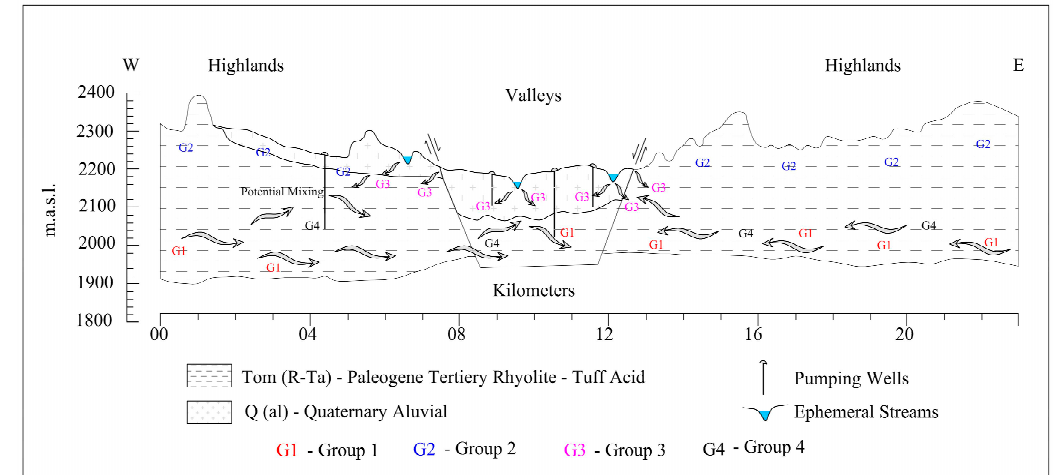
Figure 6. Cross-section illustrating the groundwater flow conceptual model and the associated clusters.